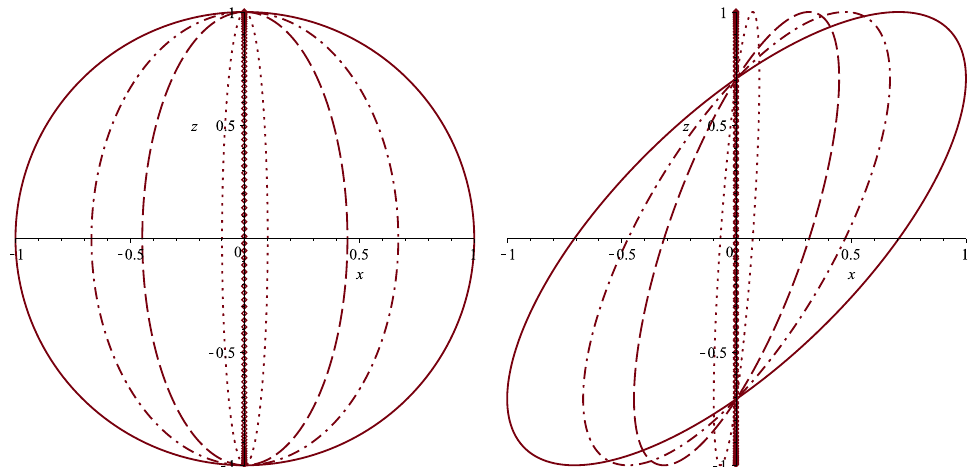
Figure 1. Plot of the parametric curves represented by (55) and (56) (left figure) for a gravitational wave (GW) with elliptic polarization H 22 = 2 H 23 and ϕ 23 = ϕ 22 ± π 2 . On the right, we displayed the plot of the parametric curves (51) and (52) for a GW with H 22 = 2 H 23 and ϕ 23 = ϕ 22 ± π 4 . They are traced by the point at which a train of particles successively fired from the origin in the y -direction hits a screen positioned perpendicularly to the y -axis at (0, L , 0). The case of massless particles is represented by the solid circle on the left and the solid ellipse on the right while the massive case is characterized by ellipses with minor axis shrinking towards the z -axis as the regime of non-relativistic velocities is approached. For both plots we considered the cases γ = 0.9 5 (dash-dot ellipse), γ = 0.5 (dash ellipse), γ = 0.1 (dot ellipse) and γ = 3.6 × 10 − corresponding to Apollo 10 spacecraft (point ellipse) which practically coincides with the line segment [− 1, 1 ] on the z -axis.